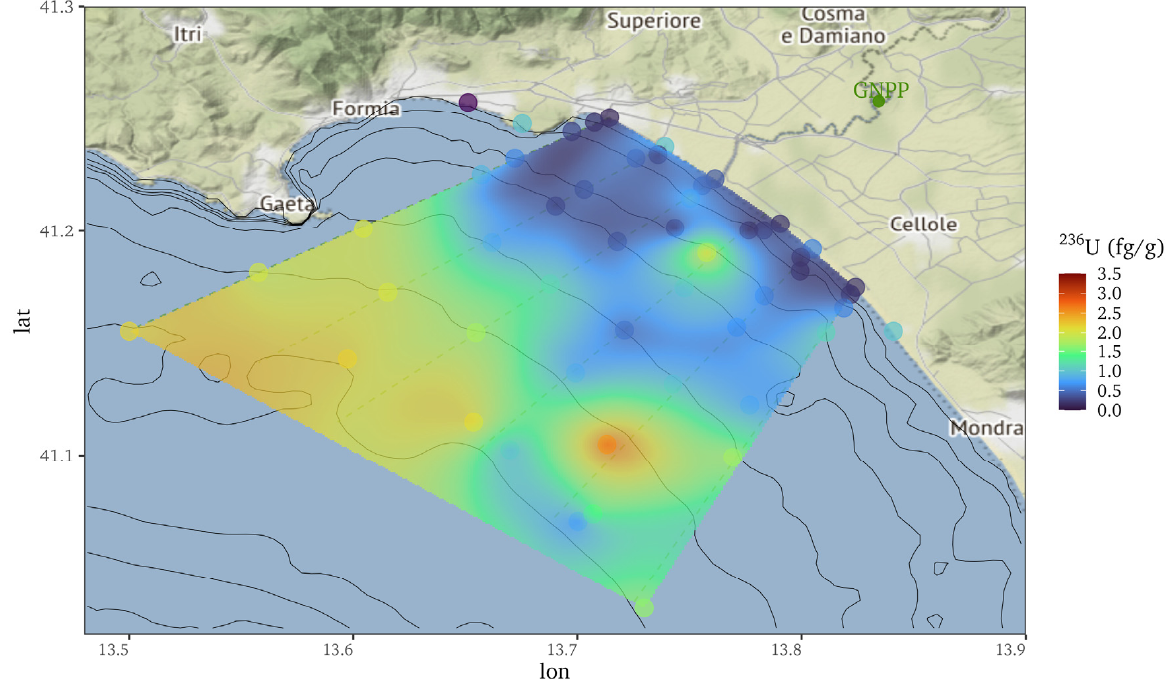
Figure 12. Map of the 236 U concentrations in marine sediments.